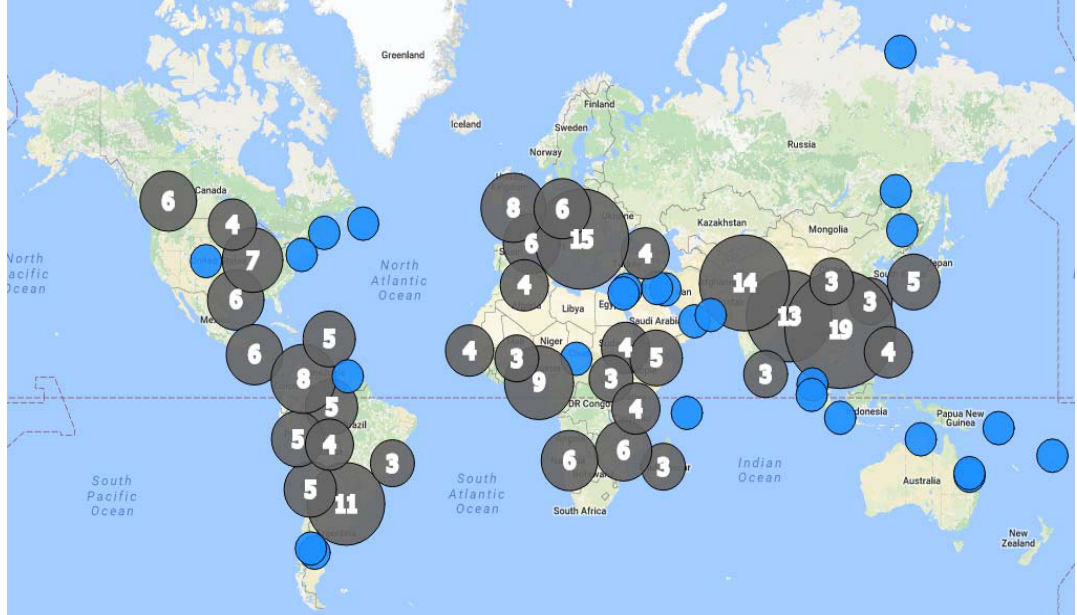
Figure 15. Map showing International Disaster Charter Flood Activations (2000–2016) (Source: Disaster Charter). Blue markers represent single activation areas, while numbers represent areas of multiple activations.